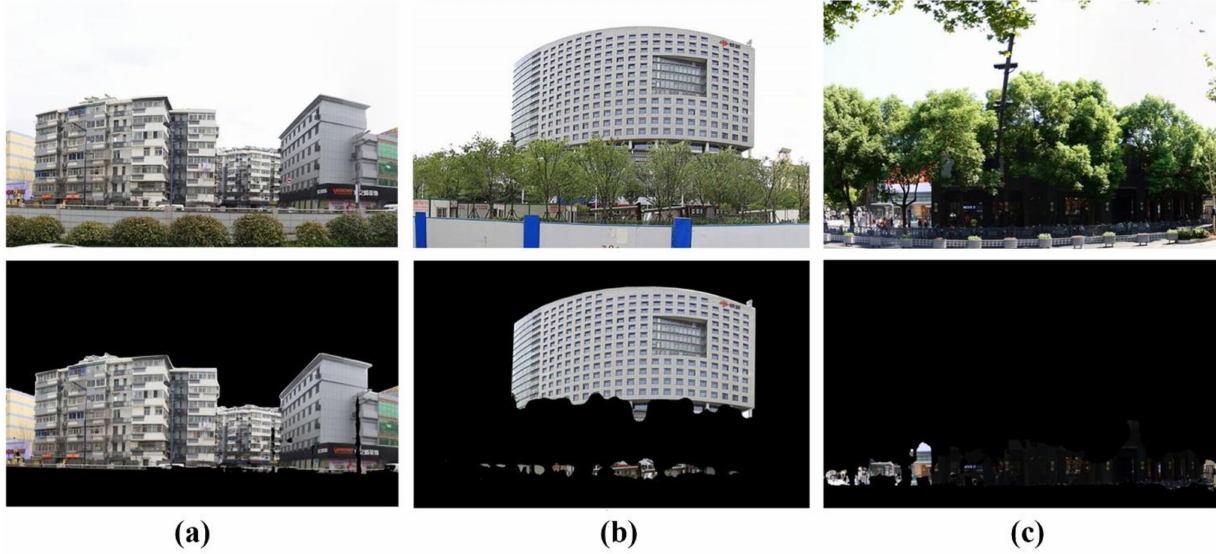
Figure 4. Street view image segmentation through Pyramid Scene Parsing Network. ( a ) Unobstructed façades, ( b ) obscured façades, ( c ) a low building